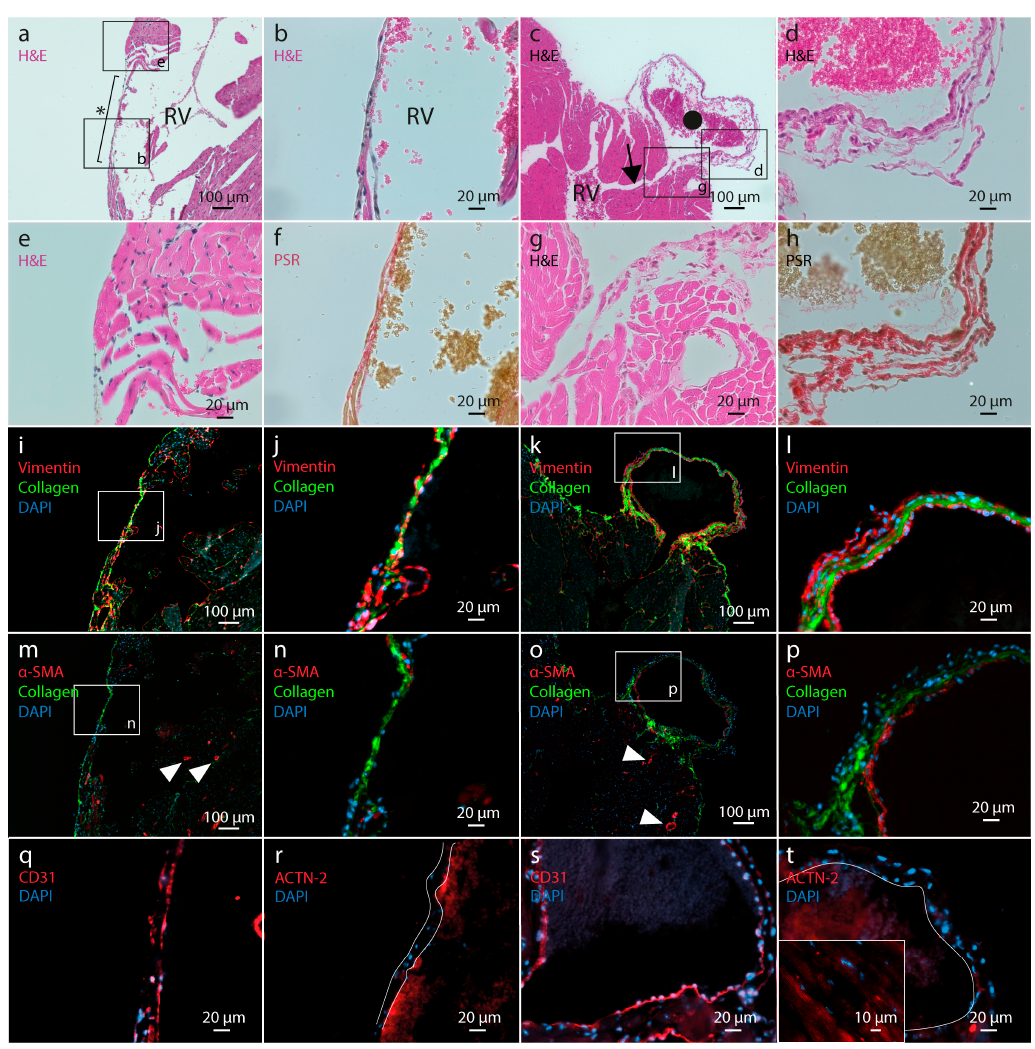
Figure 3. Microscopic analysis of tissue sections at the level of a myocardial tear and vesicle in the right ventricle free wall of the heart of MFS mice. ( a , c ): standard HE staining of representative myocardial tissue sections presenting a myocardial tear (indicated with *) and a vesicle (indicated with • ). The black arrow in panel ( c ) indicates the narrow duct in between cardiac muscle lamellae connecting the lumen of the vesicle with the lumen of the right ventricle. Black boxes indicate localization of panels ( b , d , e , g ) within the tissue sections. ( b , d , e , g ): detailed images of HE staining of the myocardial lesions and the adjacent tissue. ( f , h ): picrosirius red staining (collagen deposition) of myocardial tissue sections at the level of a tear and vesicle, respectively. ( i – l ): double fluorescent staining of vimentin and collagen (stained red and green, respectively) in myocardial tissue sections presenting a myocardial tear and vesicle. Nuclei are stained with DAPI (blue) . ( m – p ): fluorescent staining of α -SMA (red) and collagen (green), with nuclei stained blue. Arrowheads indicate α -SMA staining of vascular smooth muscle cells in the blood vessel wall. ( q , s ): immunofluorescence staining of myocardial tissue sections at the level of a tear and vesicle, respectively, with an antibody directed against the endothelial marker CD31. CD31 positive cells are stained red. Nuclei are stained with DAPI (blue). ( r , t ): immunofluorescence staining of myocardial tissue sections at the level of a tear and vesicle, respectively, with an antibody directed against the cardiac myocyte marker ACTN-2. ACTN-2 positive cells are stained red. Nuclei are stained with DAPI (blue). Boundaries of the tear are indicated with white lines in panel ( r ). Vesicle wall is indicated with white line in panel ( t ). Insert in panel ( t ) represents positive ACTN-2 staining at the level of the Z-discs of the cardiac myocytes. HE, hematoxylin-eosin staining; PSR, picrosirius red staining; RV, right ventricle.